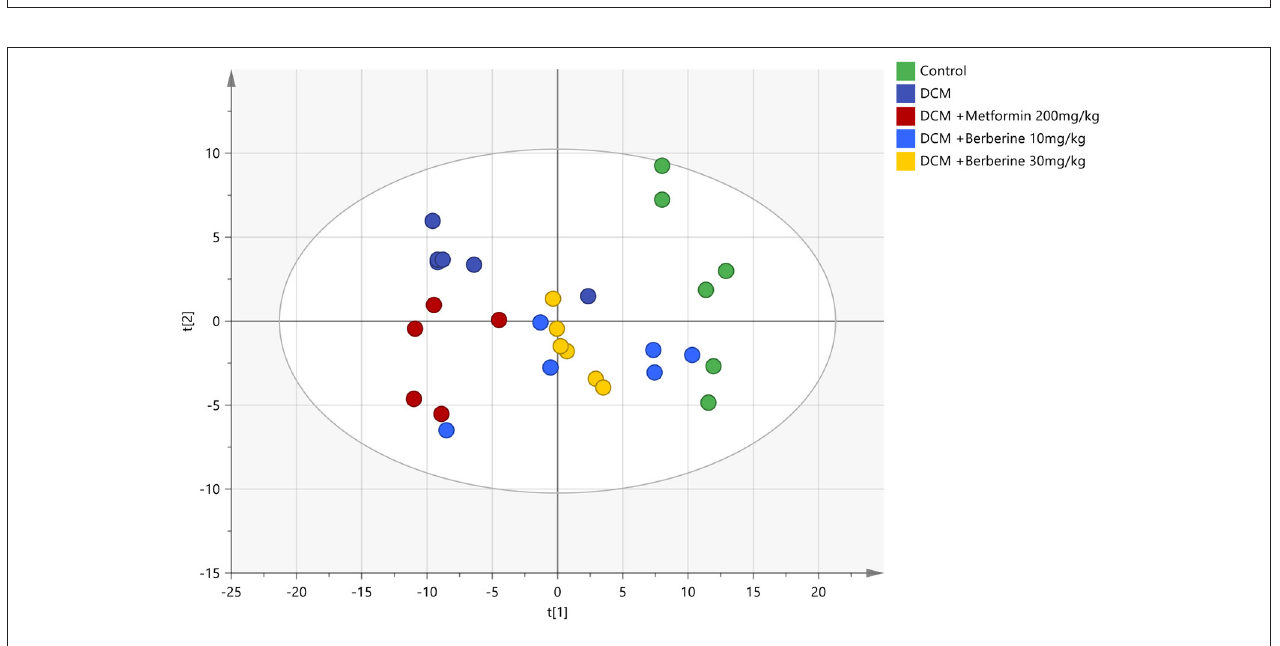
FIGURE 6 | The PCA scores plot of five groups. DCM, diabetic cardiomyopathy. The colors display the subjects from different groups. , Control; , DCM; , DCM + Metformin 200 mg/kg; , DCM + Berberine 10 mmg/kg; , DCM + Berberine 30